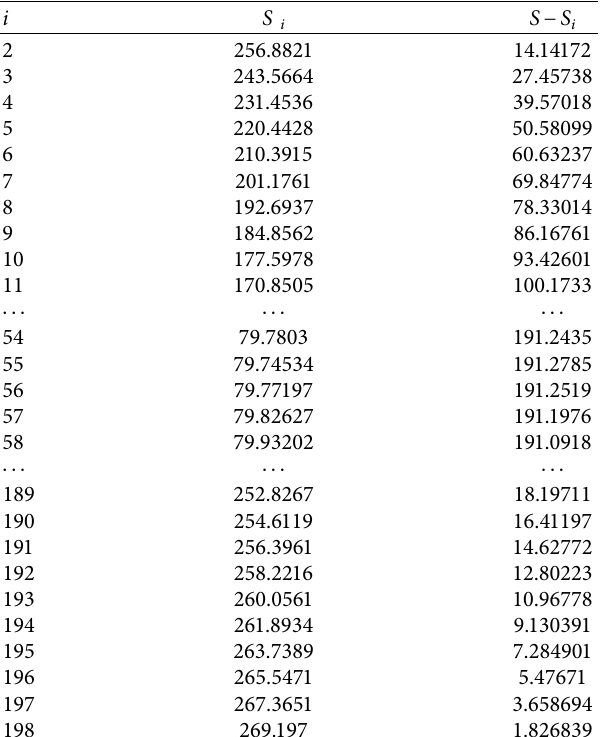
Figure 2: Fitting curve between statistic window and average relief. Table 4: Statistical results of mean change points.